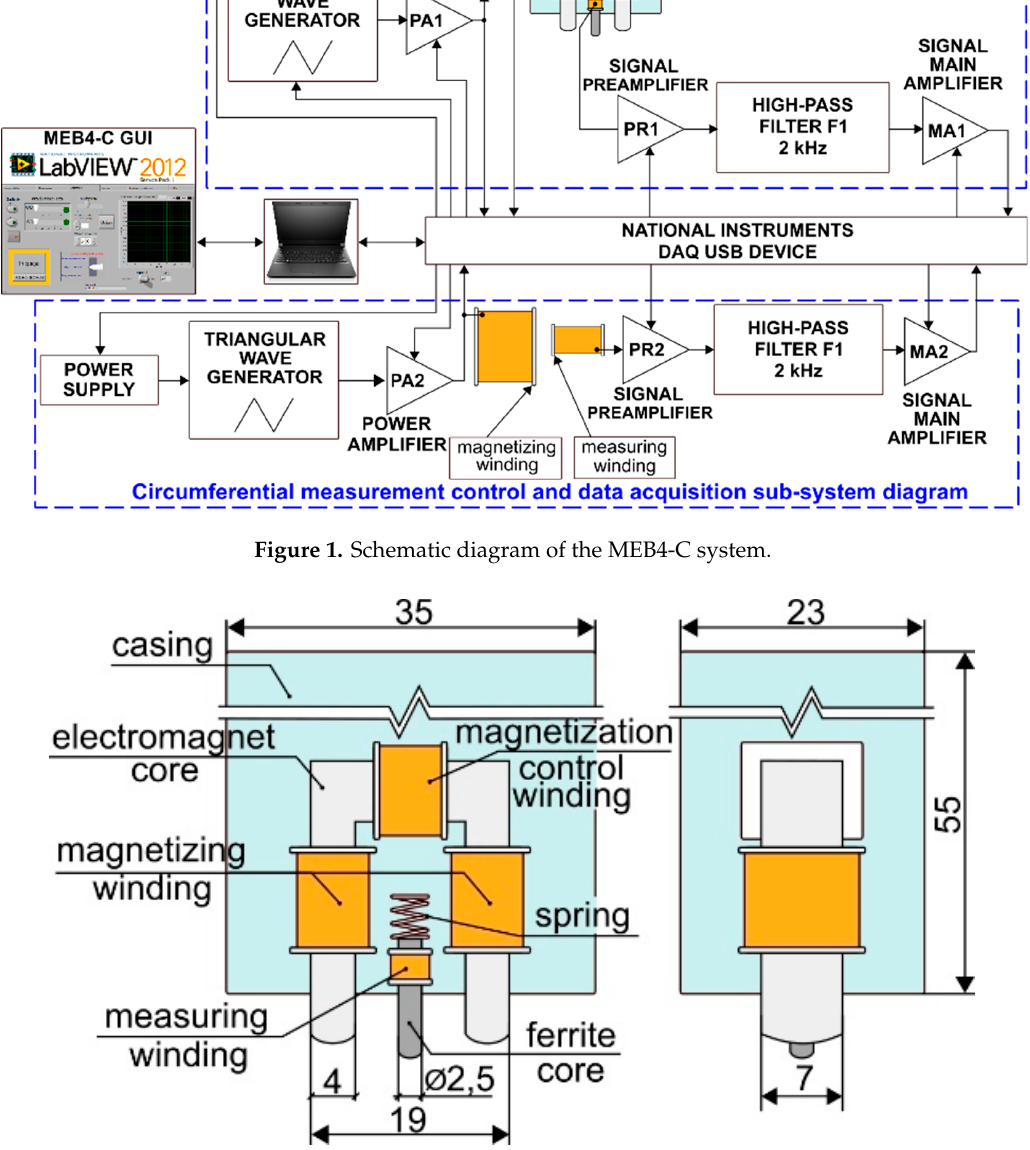
Figure 2. Surface measuring probe.